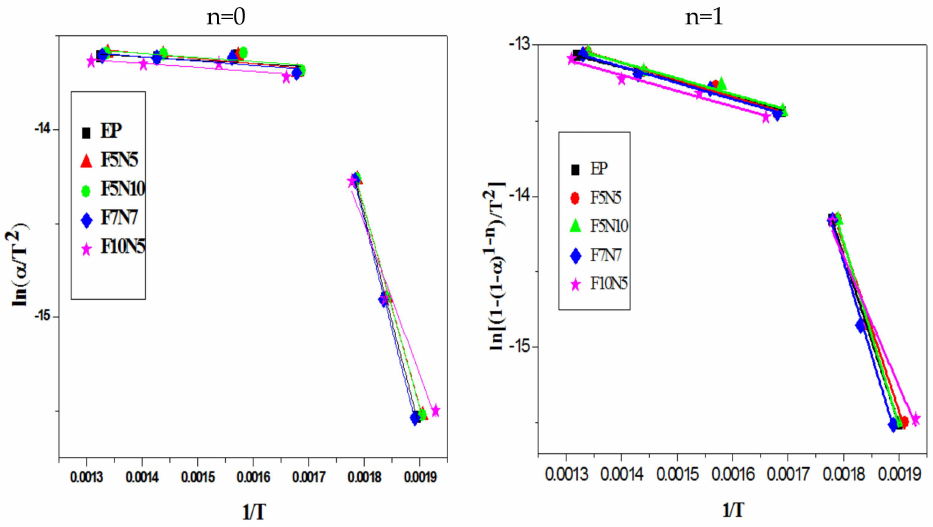
Figure 5. Pyrolysis kinetics fitting curve of di ff erent samples. Table 4. The apparent activation energy of di ff erent samples from the way of Coats–Redfern. E / kJ · mol −